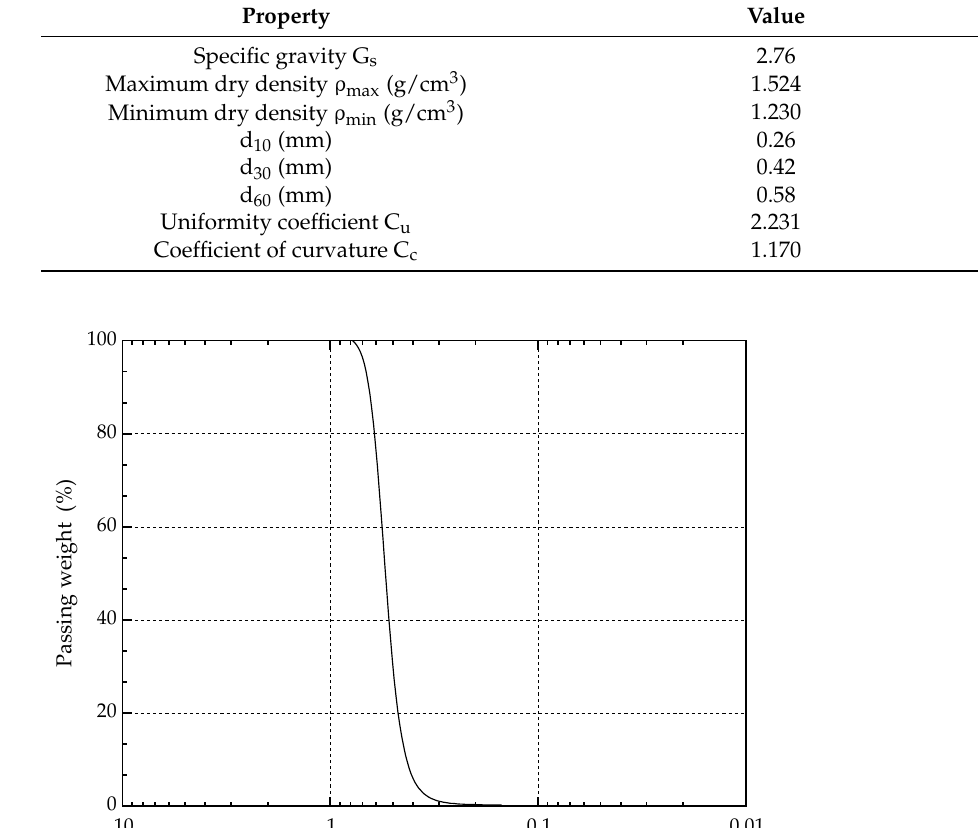
Table 1. Physical and mechanical parameters of calcareous sand.